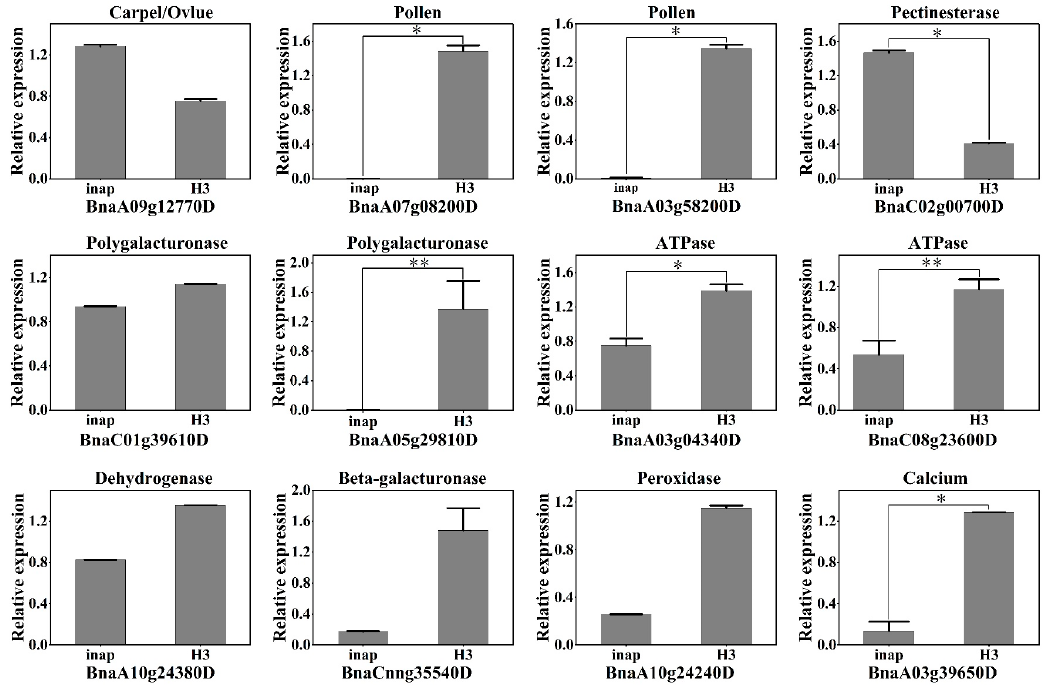
Figure 5. Real-time PCR confirmation of the relative expression of genes encoding 12 DAPs between inap CMS and its maintainer line (H3). All data are shown as the mean ± SD from three independent biological replicates. Significance at 0.01 < p < 0.05 level was marked with “*”; at p < 0.01 level was marked with “**”; while at p > 0.05 level was no marker which indicated no significant difference between inap CMS and H3.